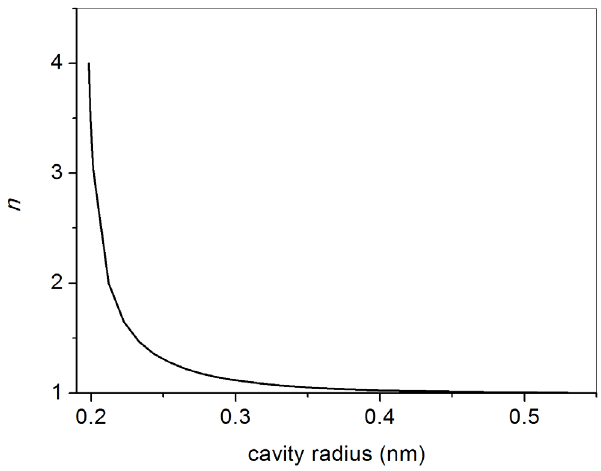
Figure 1. Dependence of the number n on the radius r 0 of the cavity trapping